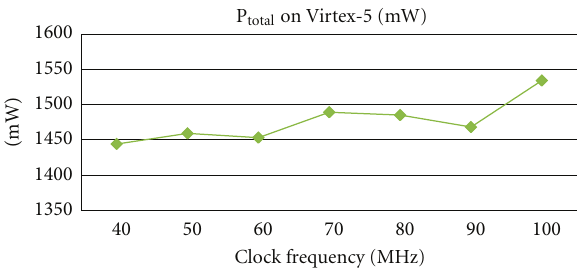
Figure 20: Impact of the clock frequency to the total power consumption of a uniprocessor design on a